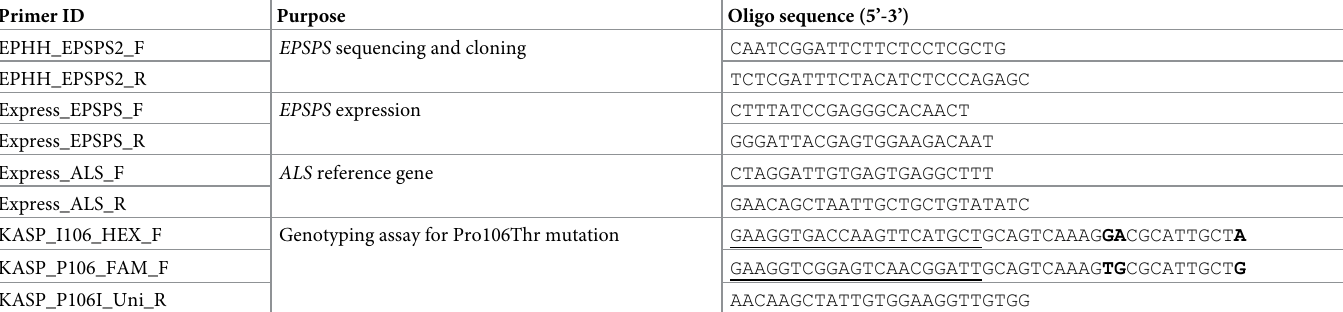
Table 1. Primers used for polymerase chain reaction (PCR) and quantitative PCR (qPCR) of glyphosate susceptible (GS) and glyphosate resistant (GR) wild poin- settia ( Euphorbia heterophylla